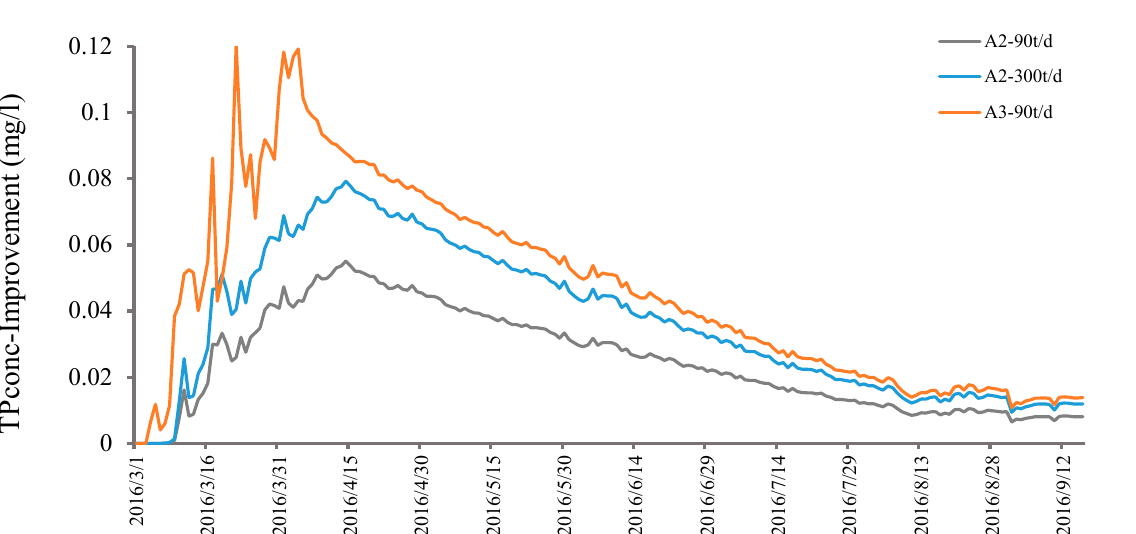
Figure 11. Response curves for the cross effect of a release position and dose (base0, T1).